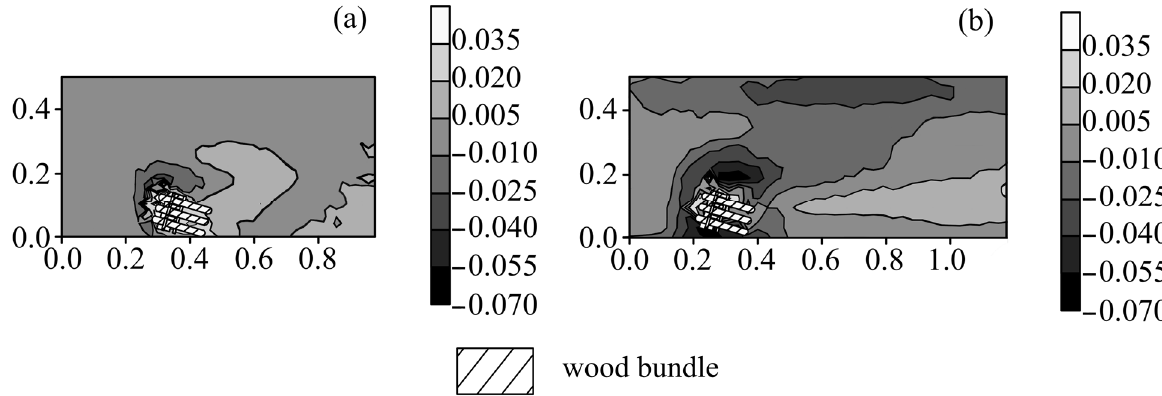
Figure 12. Scour maps for ( a ) test 38, having Type B i , and ( b ) test 49, having Type Bo . All dimensions are in metres and the flow is from left to right. 4. Conclusions Isolated and series arrangements of wood bundle structures were tested in straight and curved channels under a variety of longitudinal and transversal structure positions and hydraulic conditions. Rigorous dimensional analysis was carried out to deduce key parameters governing the scour phenomena, including the modified densimetric Froude number F * deq , accounting for both the effects of structure transversal position and channel curvature on the scour process. Empirical equations were developed to predict the main features of the scour and dune region, including maximum scour depth and length as well as the maximum dune height, and had good accuracy. For every structure position, i.e., straight, inner channel bank and outer channel bank, two different types of scour mor- phology were classified, and their fields of existence were quantified based on F* deq and h st / h tw or R / h tw . By decreasing the tailwater level or by increasing the Froude number, a